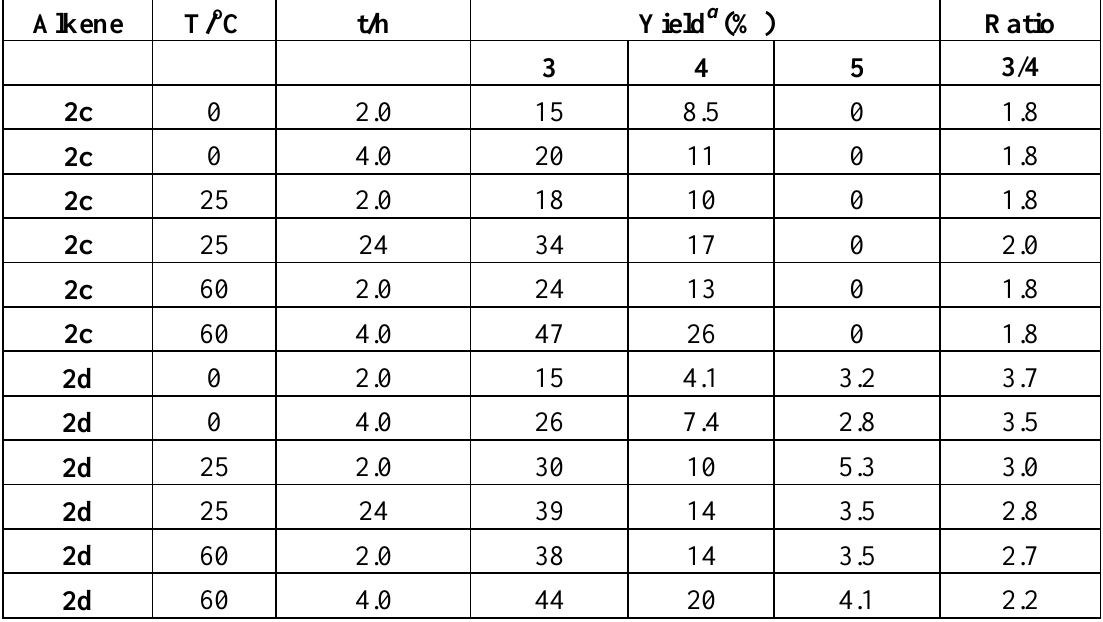
Table 2. Reactions of dimethyl disulfide 1 (2.0 mmol) with 2-methylpent-1-ene 2c